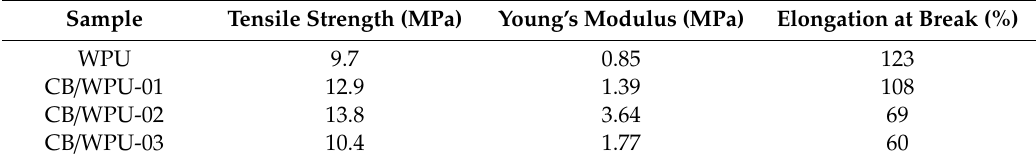
Table 4. Tensile properties of the CB/WPUs.